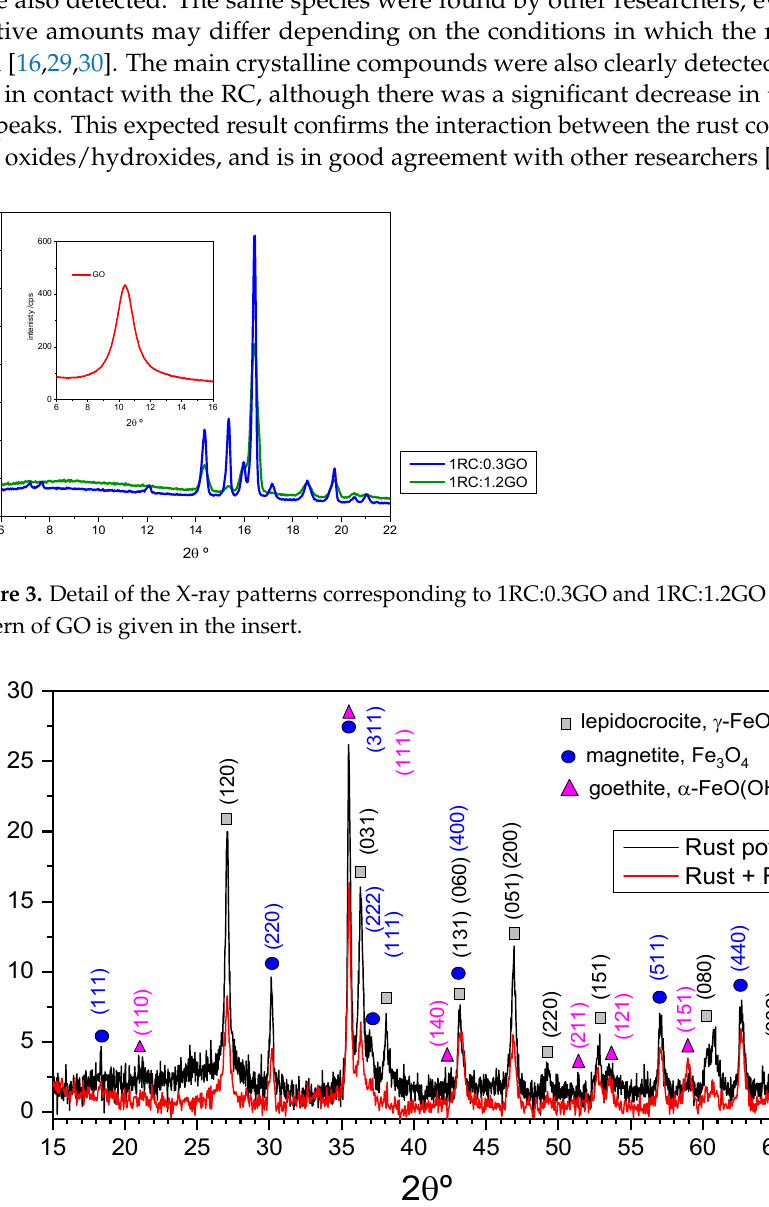
Figure 4. X-ray patterns obtained for dried rust powder and rust + RC mixture after being in contact for 15 days. The identification of the main crystalline compounds is also included together with the diffraction planes in each identified species based on refs.